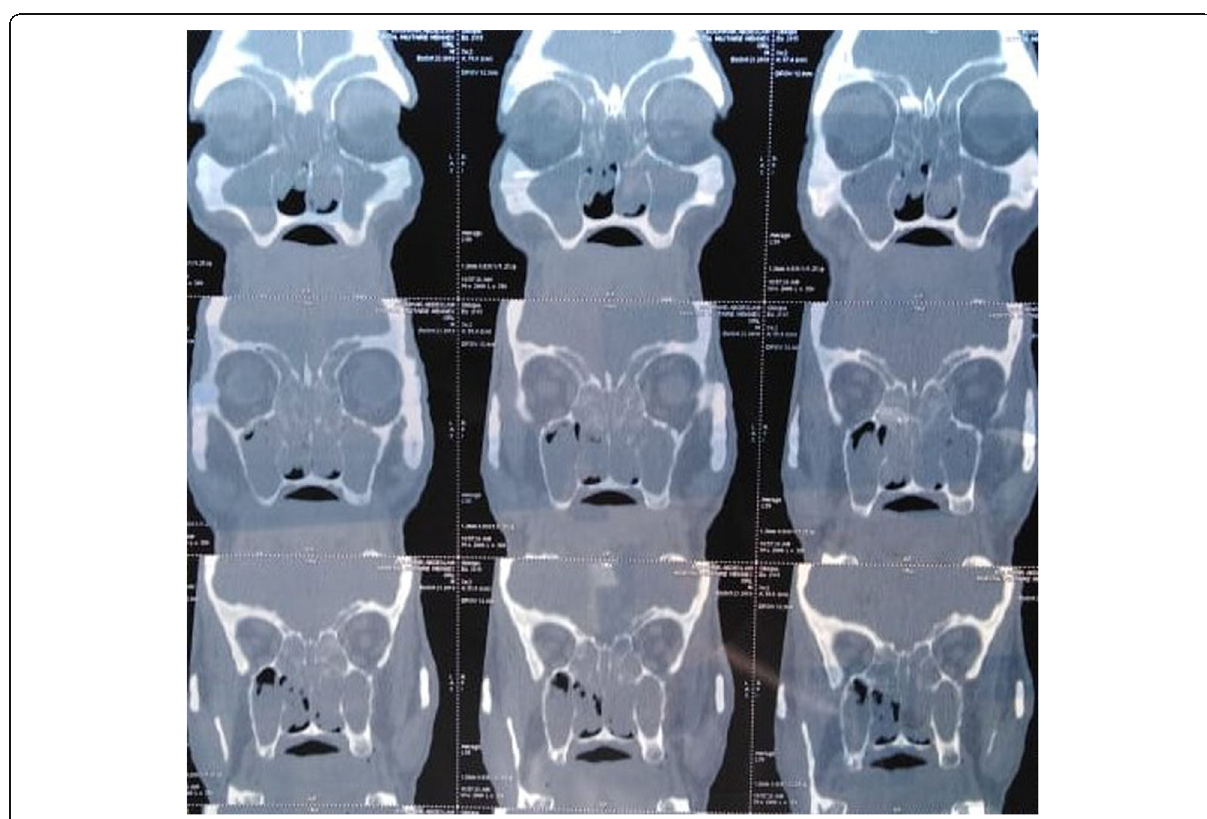
Fig. 1 Coronal computed tomography (CT) scan sections of sinus cavities: showing an enlarged maxillary meatus, with blocked maxillary, frontal and sphenoidal sinuses, without bone